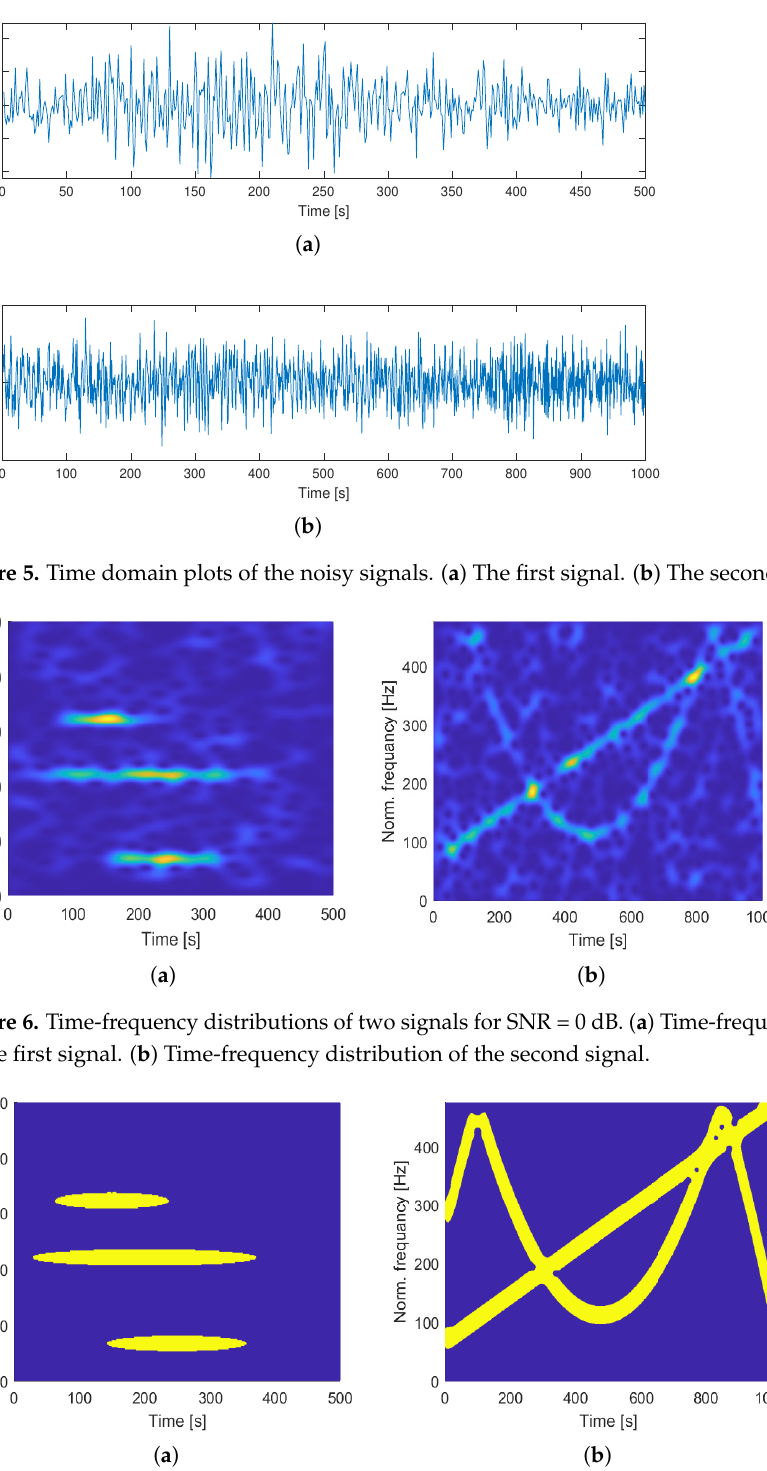
is measured using the accuracy and F1